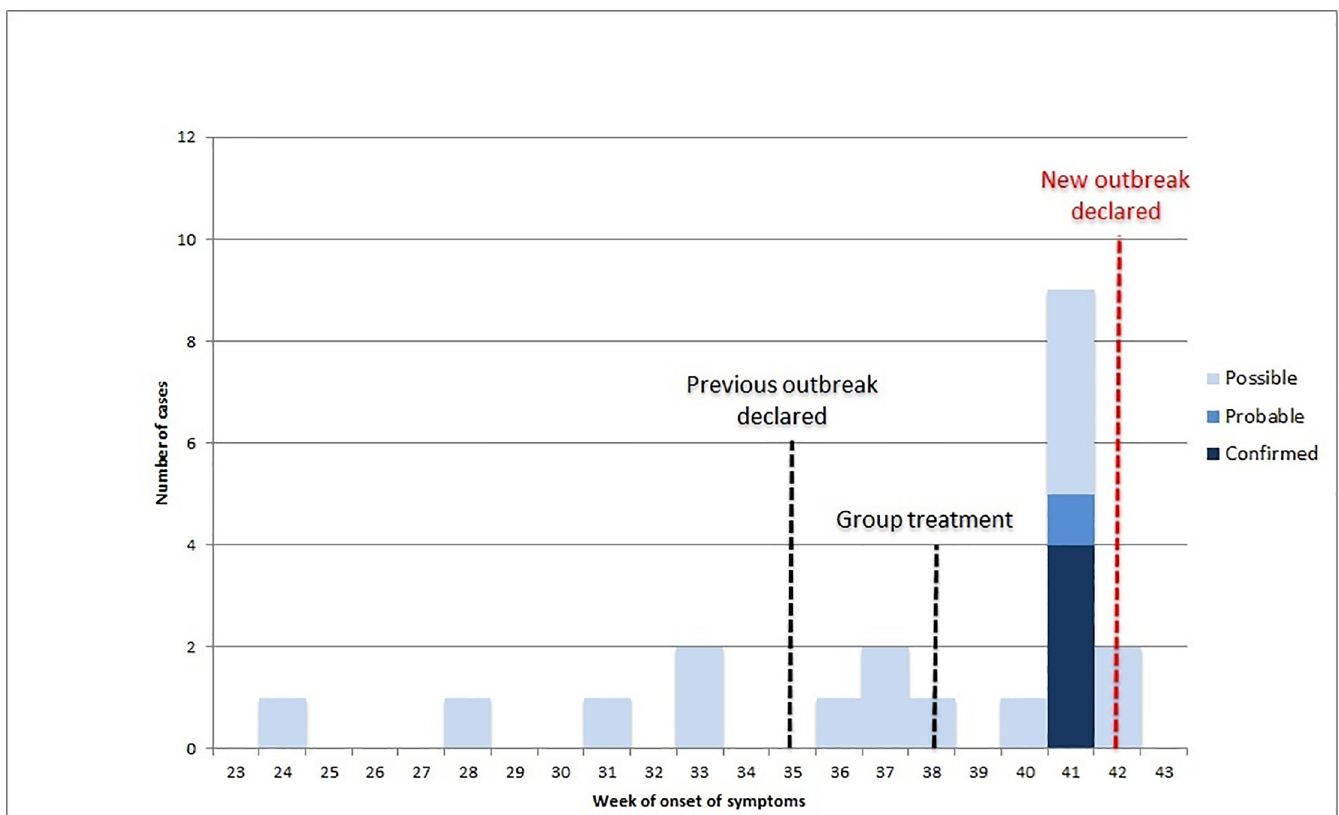
Fig 1. Epidemic curve of scabies cases among staff members and residents. The date of onset was available for 21 out of the 40 cases.